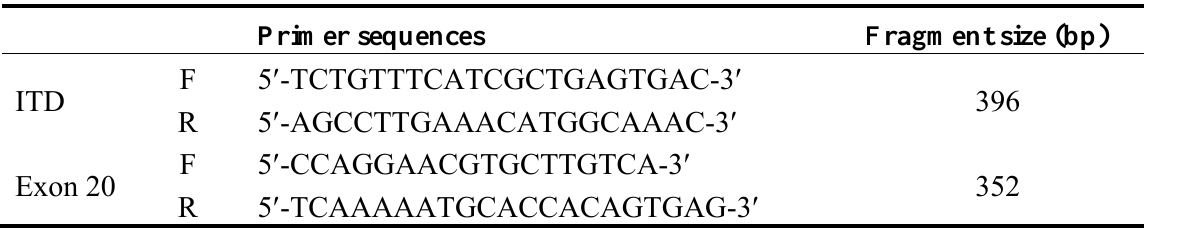
Table 2. Oligonucleotide primers used in PCR